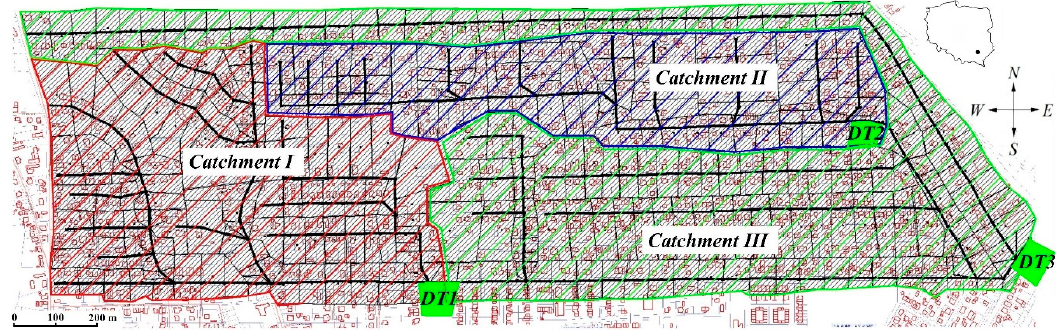
Figure 1. The stormwater drainage system and the location of multi-chamber detention tanks.